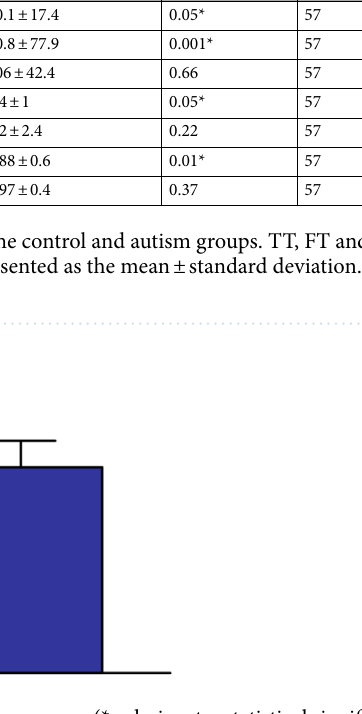
Figure 1. DHEA in both the control and autism groups (* = designates statistical significance compared to